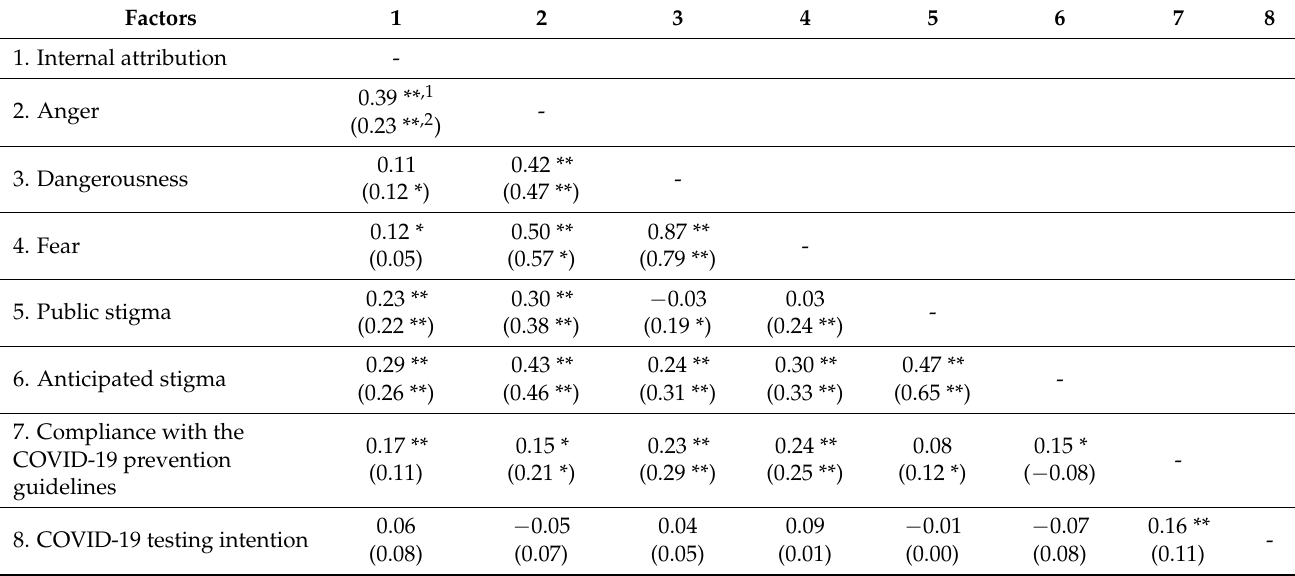
Table 2. The correlation matrix for the two age